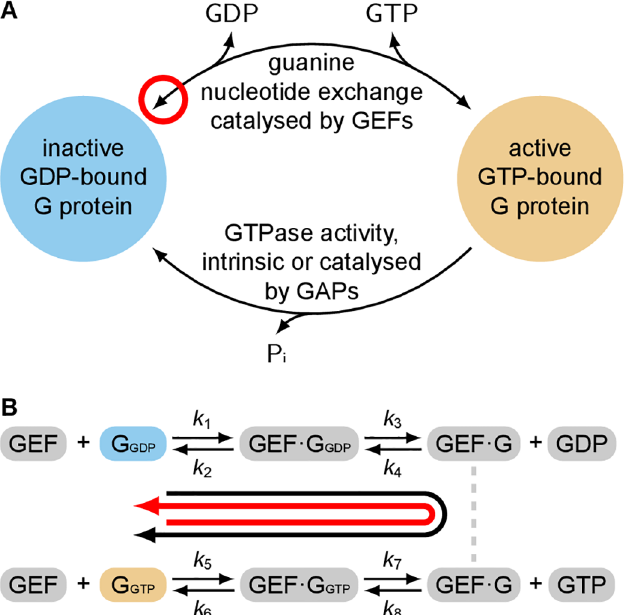
Fig 1. The activation of G proteins is regulated by GEFs and GTPase activity. A G proteins are controlled by GEFs which catalyse the sequential release and binding of guanine nucleotides, and by GTPase activity (both intrinsic and GAP-mediated) which hydrolyses bound GTP to form GDP and Pi. The red circle highlights that the GEF mechanism is completely reversible. B The reversible mechanism by which a GEF catalyses guanine nucleotide exchange on a G protein proceeds through a series of GEF (cid:1) G protein complexes [13]. Parameters k i are kinetic rates which are unique to each G protein:GEF system. Associated species (free GEF, GTP, GDP) have not been drawn. The thick black arrow identifies forwards nucleotide exchange, catalysing the activation of the G protein. The thick red arrow identifies reverse nucleotide exchange, catalysing the inactivation of the G